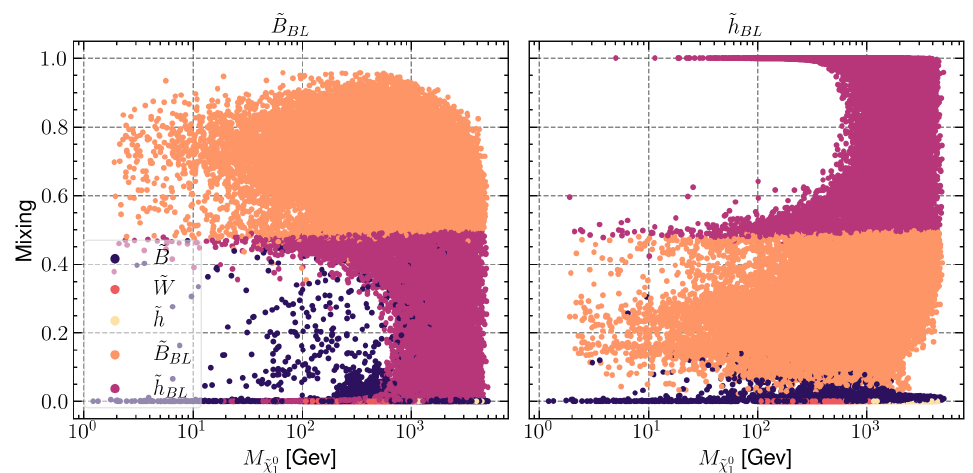
Figure 2: The size of the (cid:101) B (left) and (cid:101) h (right) components for the LSPs in all BL BL models that have passed the cuts of table 2, in addition to requiring Ω h 2 < 0.15. Colour coding is the same as for figure